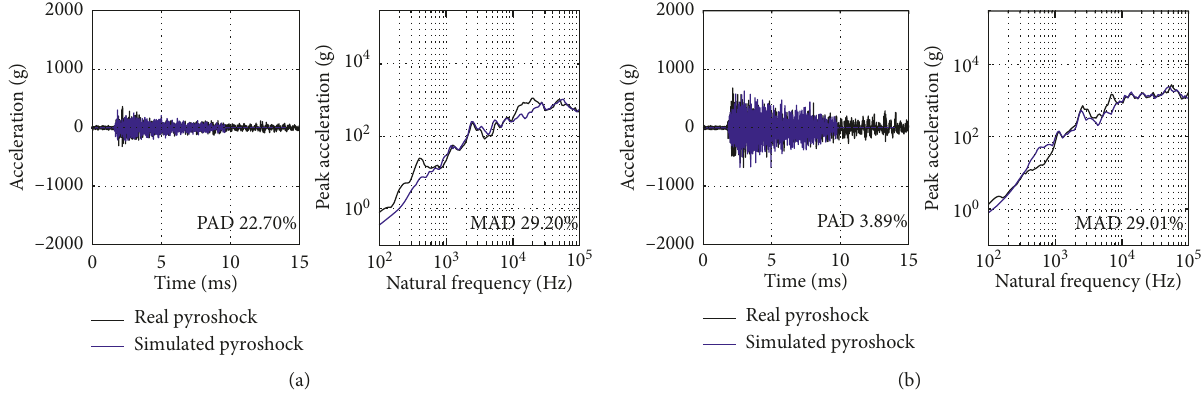
Figure 9: Simulation results of 1/2 inch pyrolock-induced shock at training points: (a) Point 1 and (b) Point